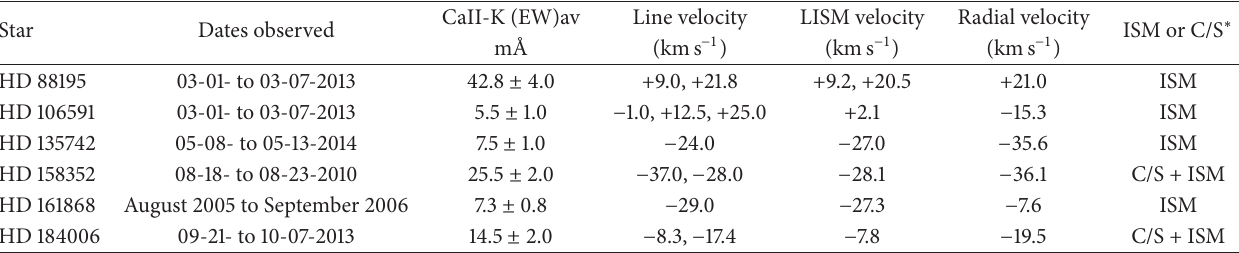
Table 3: Stars showing no change in CaII K-line absorption.